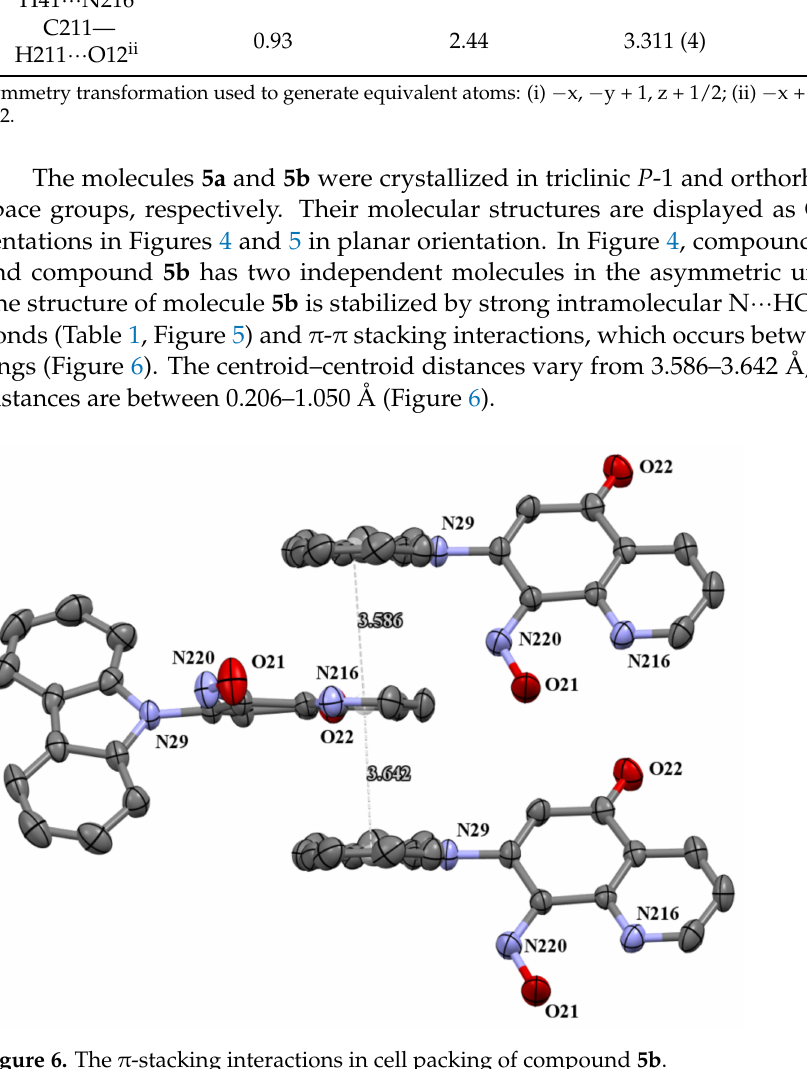
Figure 6. The π -stacking interactions in cell packing of compound 5b . Compounds 5a and 5b are composed of an 8-nitroquinoline core in a planar orienta- tion and peripheral amino substituent. The 9 H -carbazol-9-yl substituent is strongly twisted in relation to the quinoline rings with a larger angle (86.43 ◦ , 84.98 ◦ , 67.96 ◦ ) for 5a and (~54.73 ◦ ) for 5b between quinoline and 9 H -carbazol-9-yl substituent planes in the posi- tion C7. It is worth noting that bond lengths between the carbon atom at C7